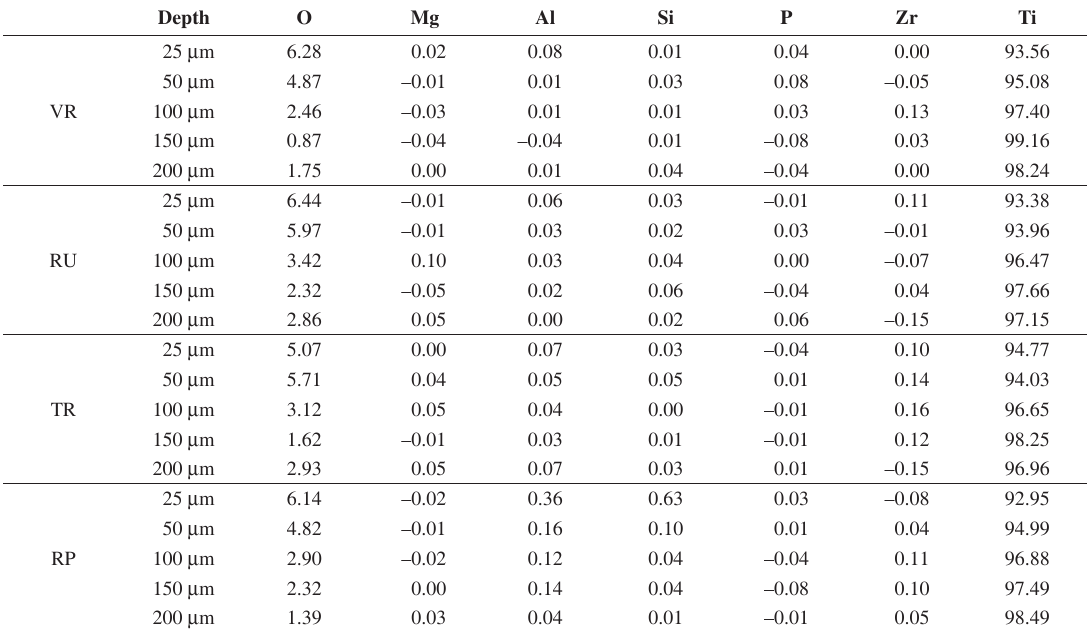
Table 5. EDX elemental composition analysis of the interfacial zone reaction (by weight %). Depth